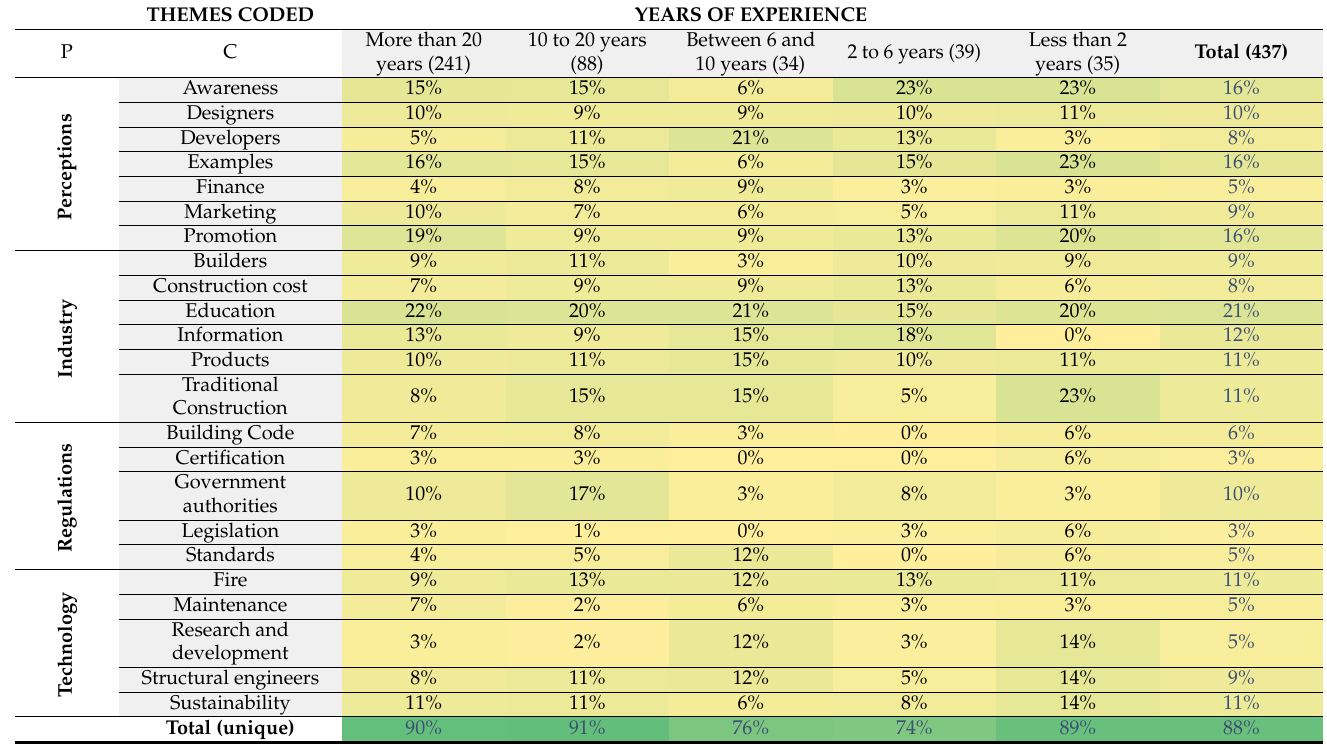
Table A2. Heat map of themes identified as critical for adoption, filtered by years of